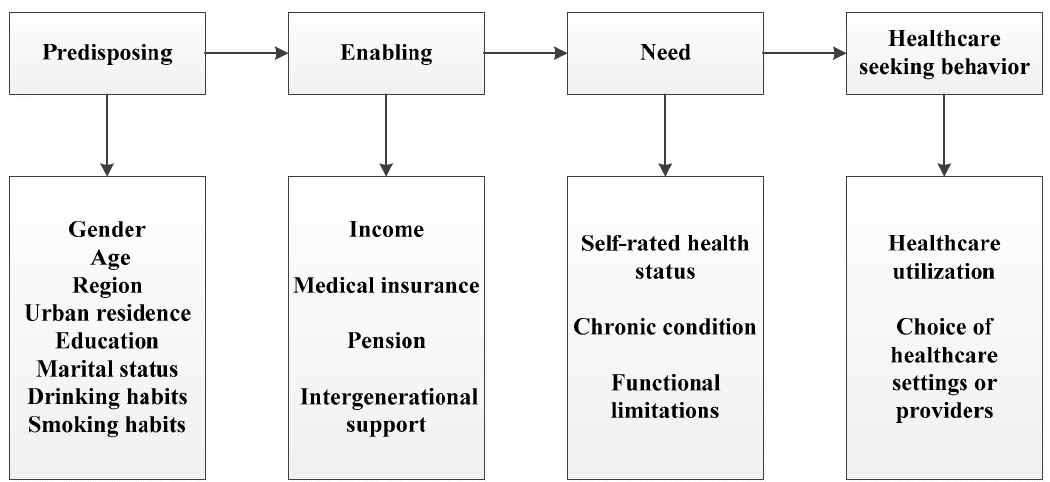
Figure 1. The Anderson theoretical model of influencing factors on healthcare-seeking